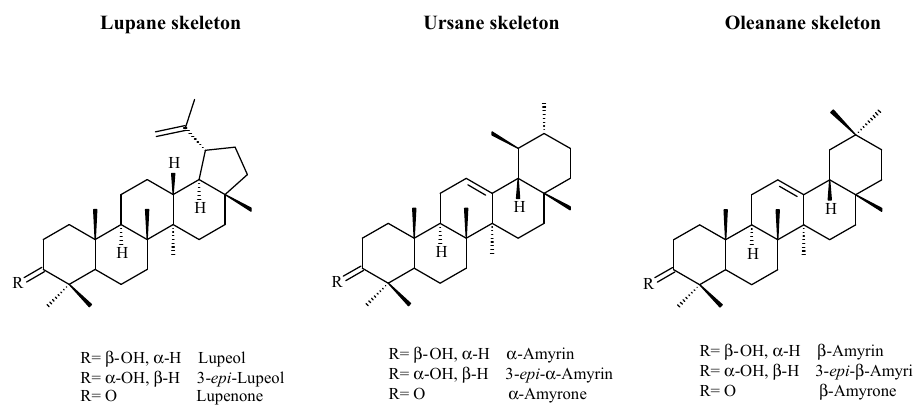
Figure 1. Triterpenoid markers used in GC-MS analysis of copal [16].